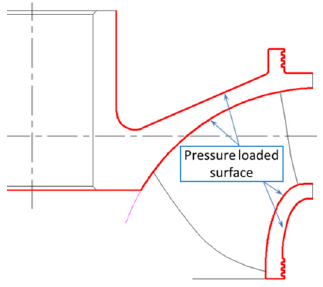
Figure 17. Runner hub and shroud surfaces for pressure loading.